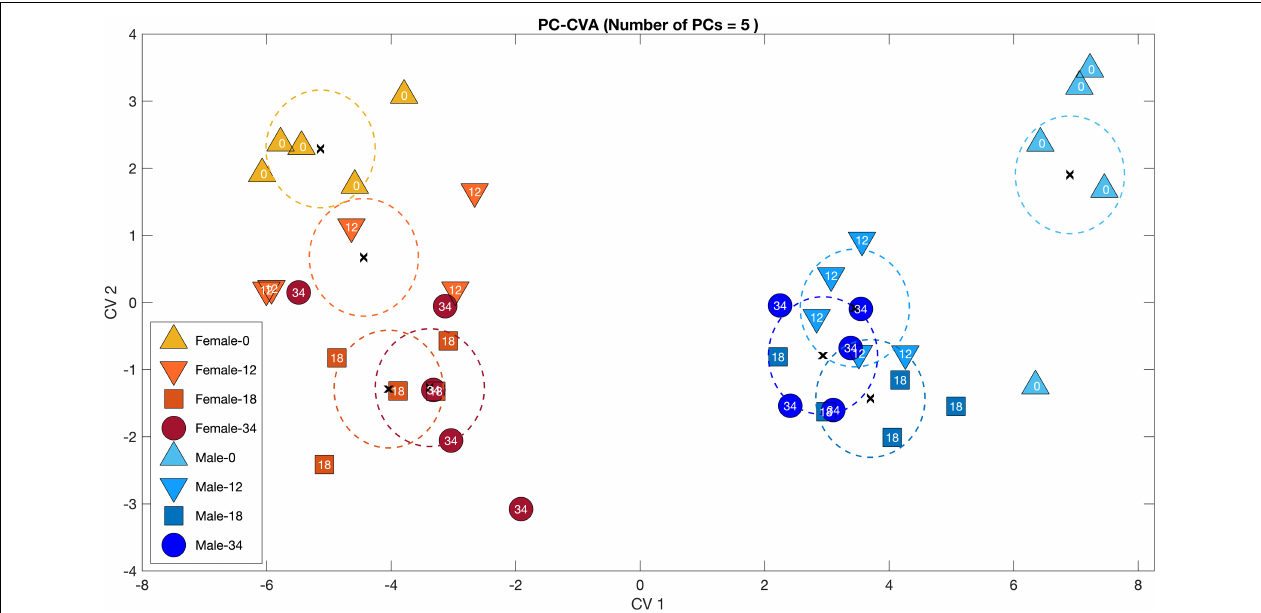
FIGURE 3 | Principal component-canonical variate analysis (PC-CVA) of the relationship between metabolomic profile, sex and time from Cherax tenuimanus haemolymph samples. Males in cool colours (blues) and females in warm colours (reds). Numbers represent time in days and colours increase in intensity with time. At day 0, animals are unpaired and by day 12 all animals were paired and remained so for the rest of the experiment. X: mean of each group; dashed lines: 95% confidence intervals of the mean of each group. The PC-CVA model was constructed using five principal components.